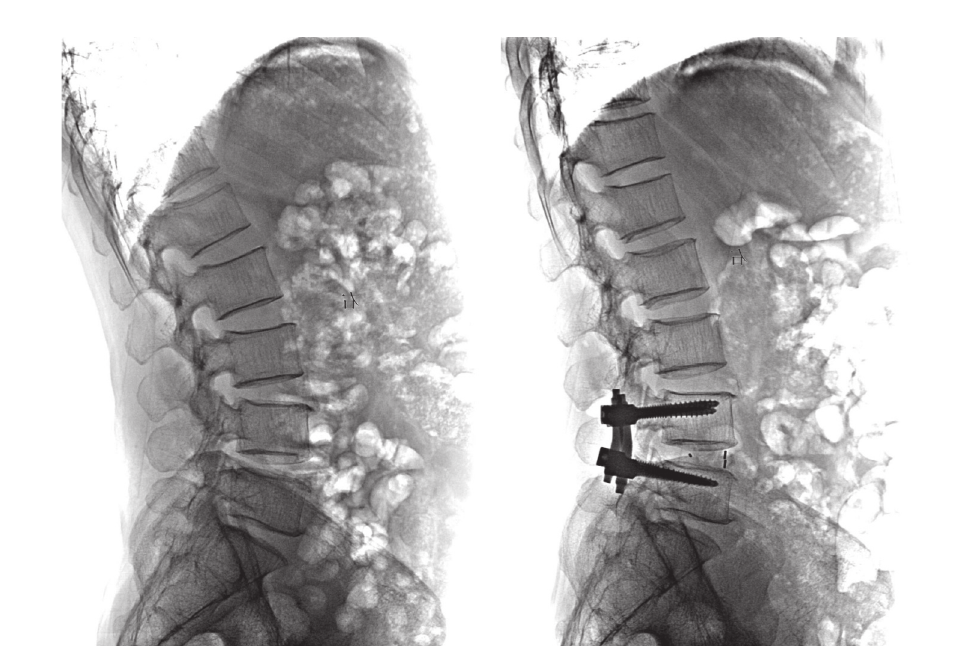
Figure 2: Flow of patients through the study.